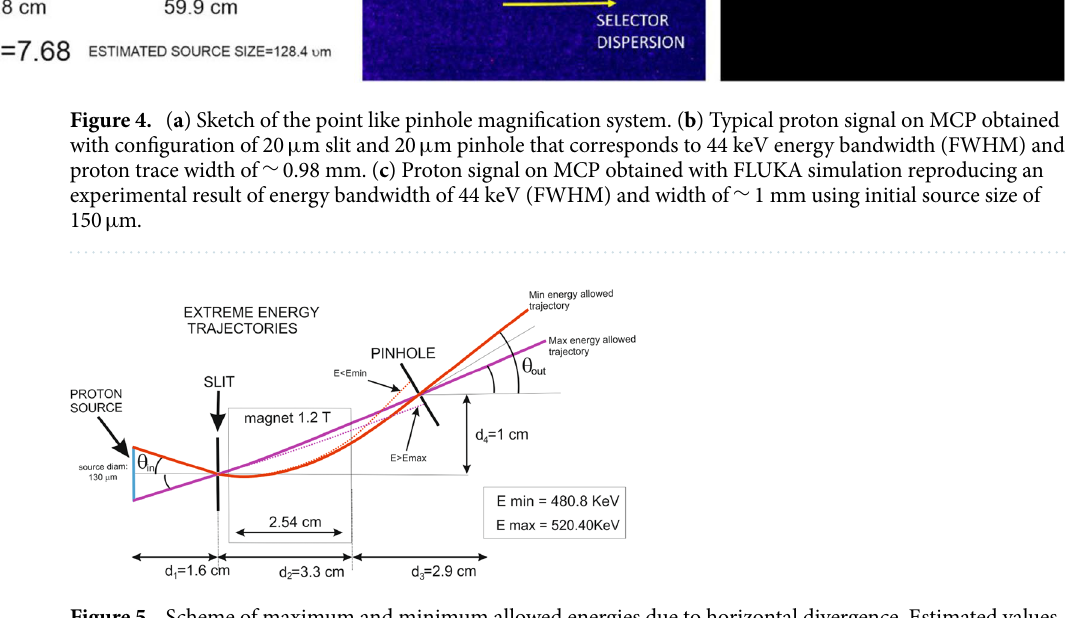
Figure 5. Scheme of maximum and minimum allowed energies due to horizontal divergence. Estimated values using simple gyroradius model in a square B field are